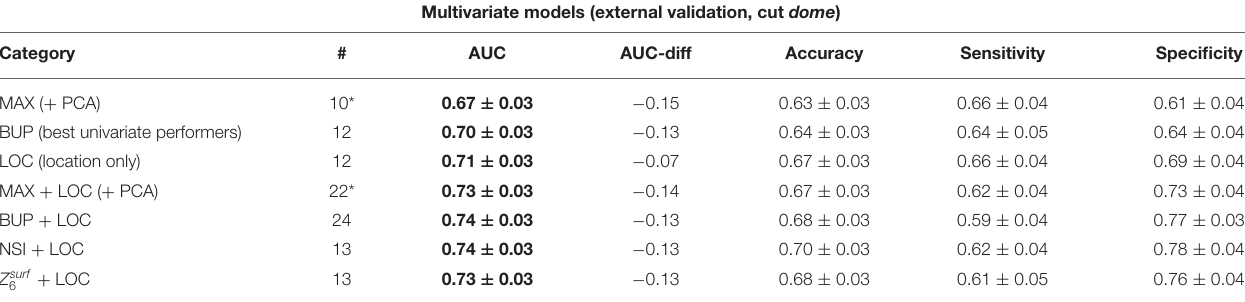
TABLE 8 | External validation results of the same multivariate models of Table 6